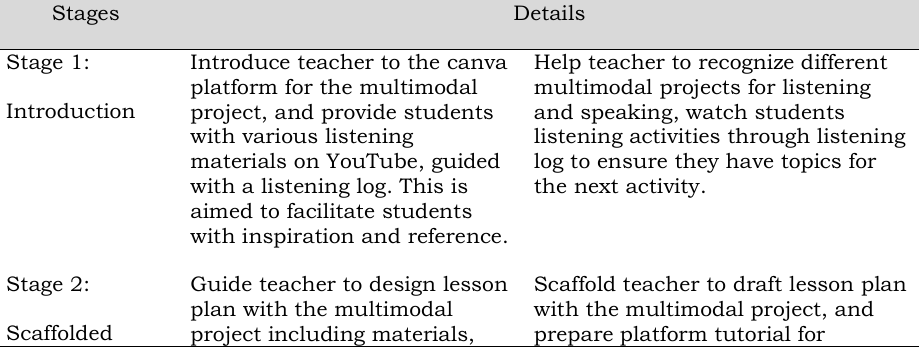
Table 1. The stage of multimodal